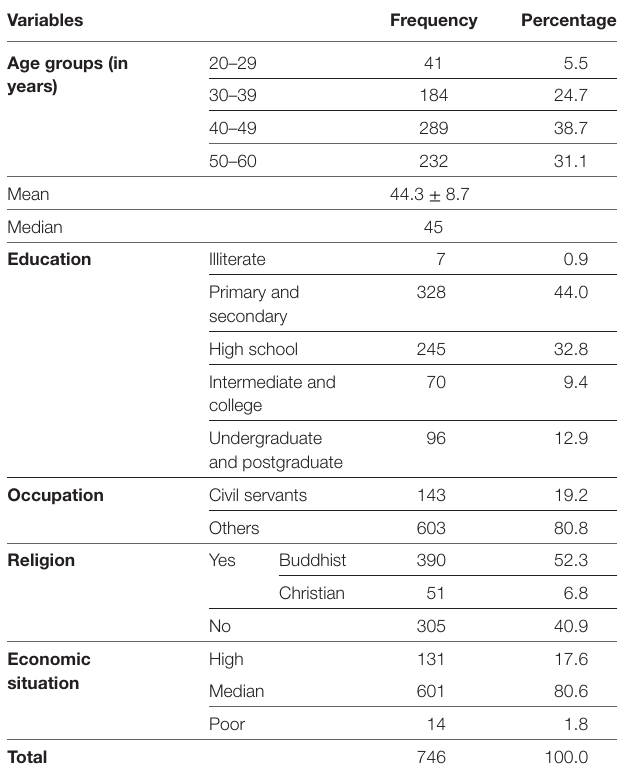
TaBle 1 | Demographic information of respondents ( n =